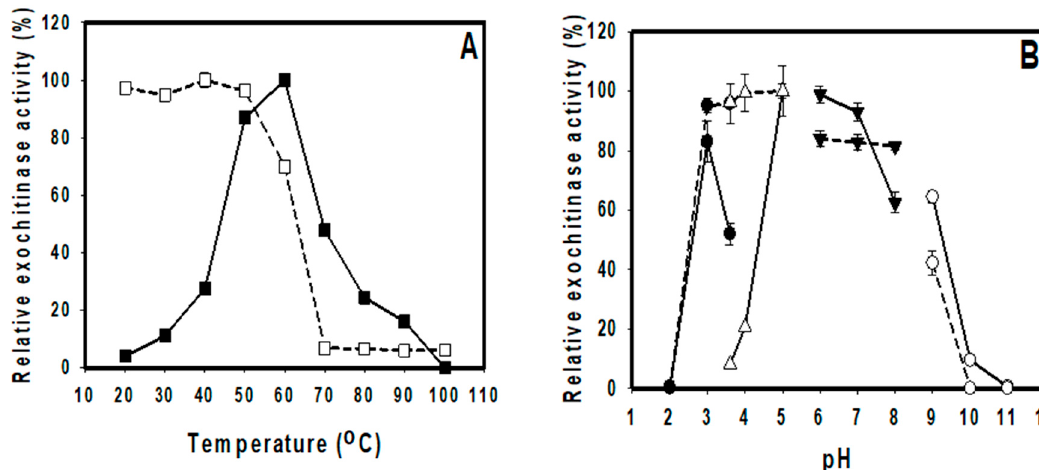
Figure 4. Effects of temperature ( A ) and pH ( B ) on the activity and stability TKU048 exochitinase: (—) optimum; (…) stability; ( ) glycine HCl buffer; ( ) sodium acetate buffer; ( ) sodium phosphate buffer; and ( ) sodium bicarbonate–carbonate buffer.